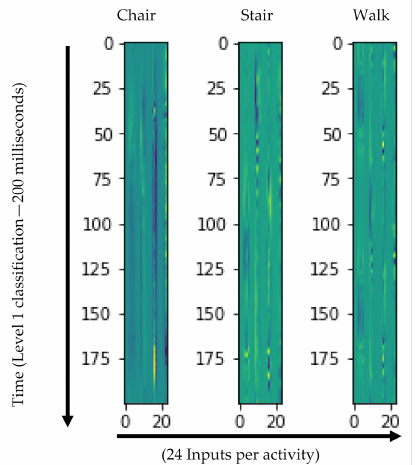
Figure 3. Visual representation of Level 1 activity ‘image’ patterns.